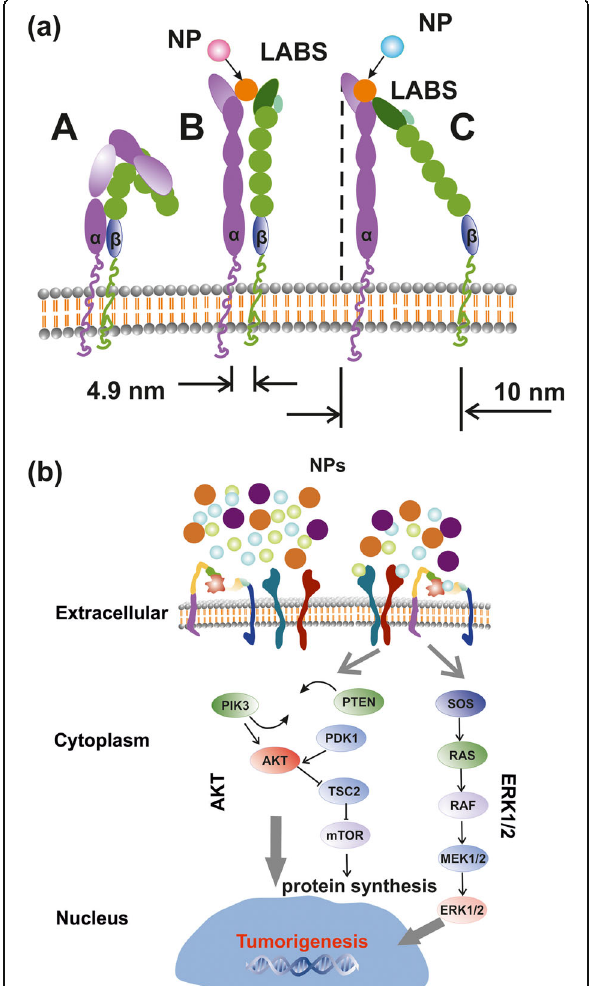
Fig. 10 Simplified layout of integrin activation by NPs and signal transaction pathways. a Structure and conformational geometries of integrins at a low (A), medium (B) and high-affinity strengths (C). b AKT and ERK1/2 signal transaction pathways activated by RE-NPs via external integrin